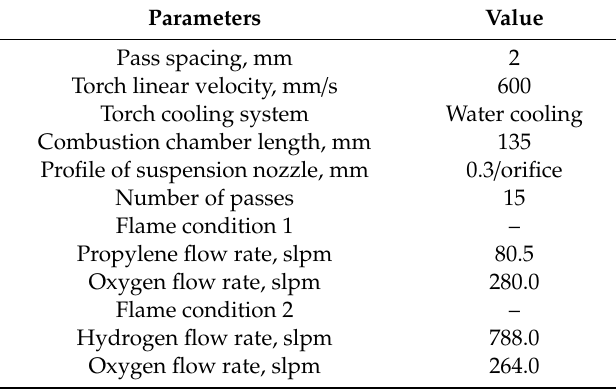
Figure 1. ( a ) Schematic of the suspension HVOF system for nanostructured TiO 2 coating. ( b ) Digital image of the HVOF propylene flame with suspension. Table 2. Main suspension HVOF spraying parameters .